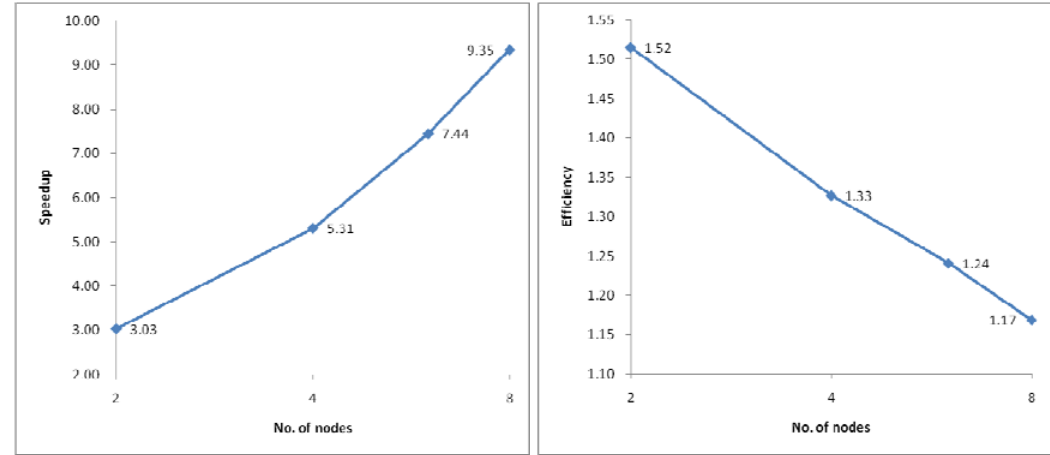
Figure 11a. Speedup for dataset 4. Figure 11b. Efficiency for dataset